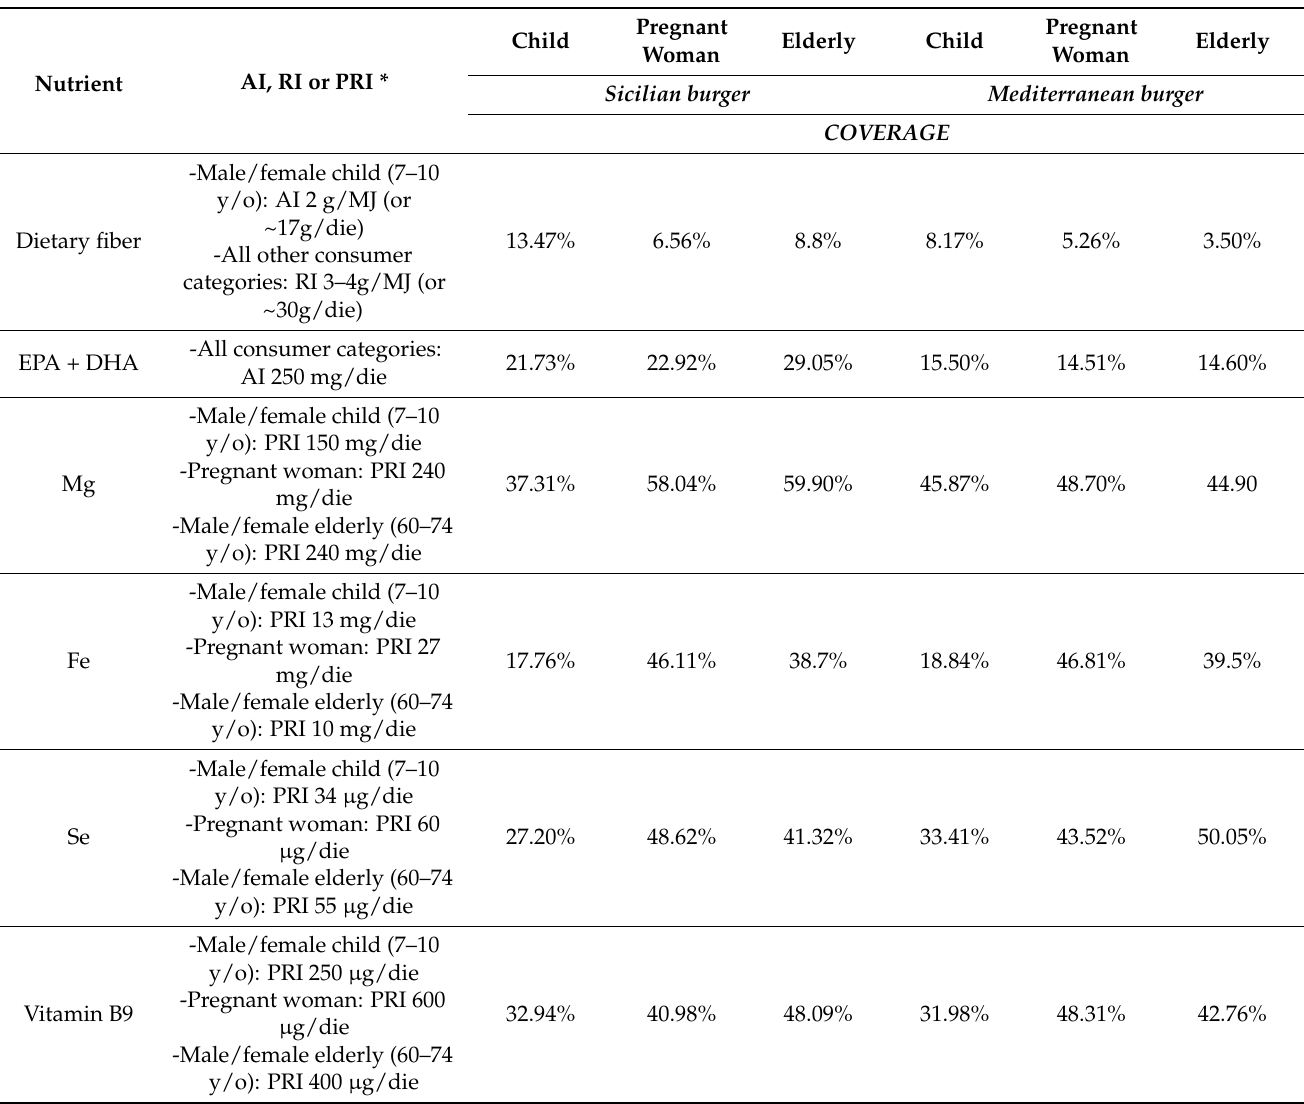
Table 6. Evaluation of the coverage of adequate intake (AI), reference intake (RI) or population reference intake (PRI) of fortifying nutrients derived from the daily consumption of Sicilian and Mediterranean burgers (100 g) by various consumer